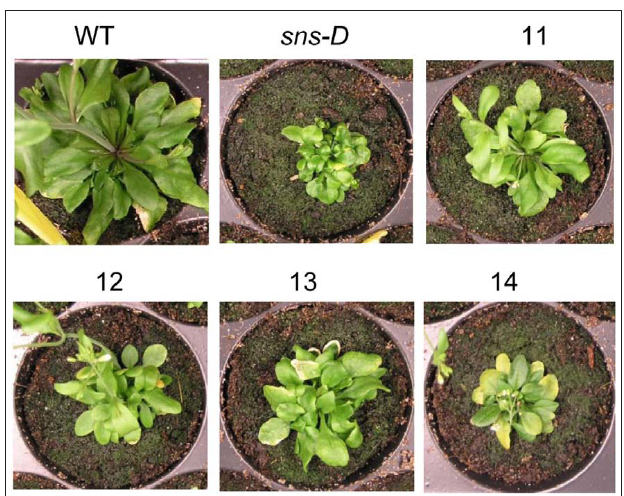
FIgURe 13 | Phenotype of At1g13020 overexpression lines. Five-week-old plants were grown on soil; overexpression lines (11, 12, 13, 14), the sns-D mutant and the